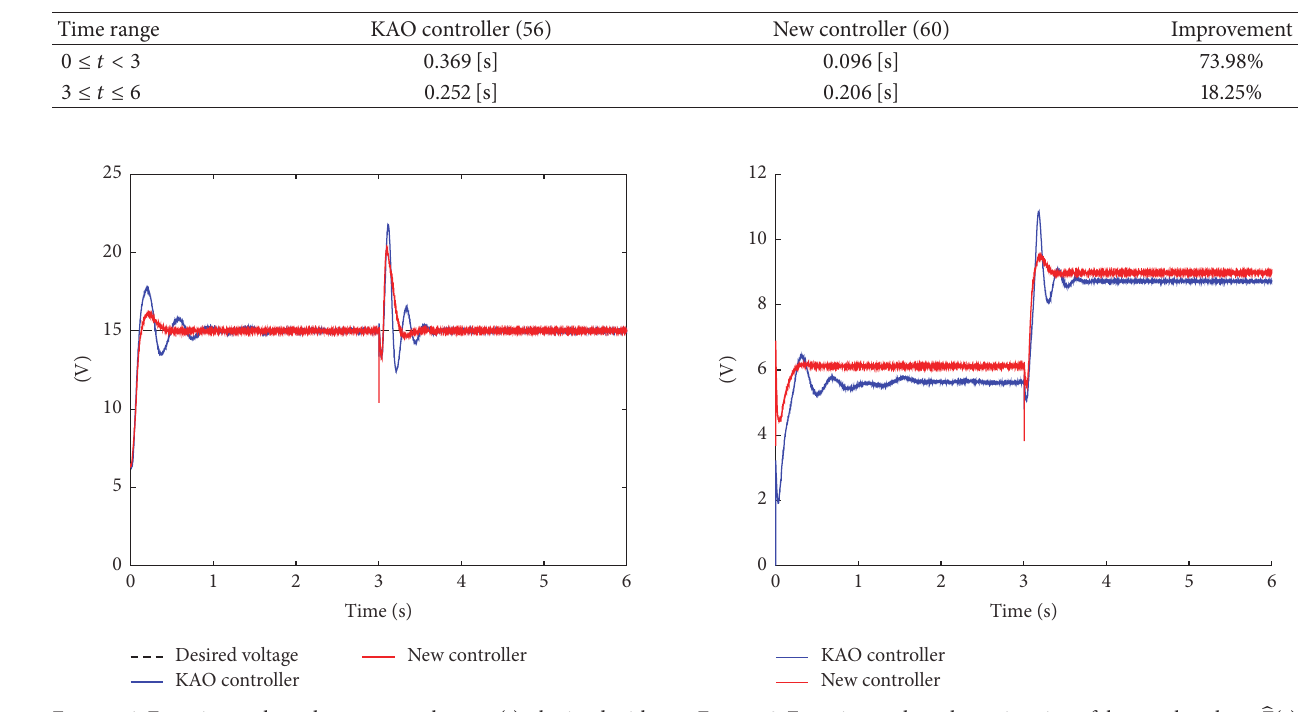
Figure8:Experimentalresults:estimationofthesupplyvoltage obtained with the KAO controller (56) and with the new controller in